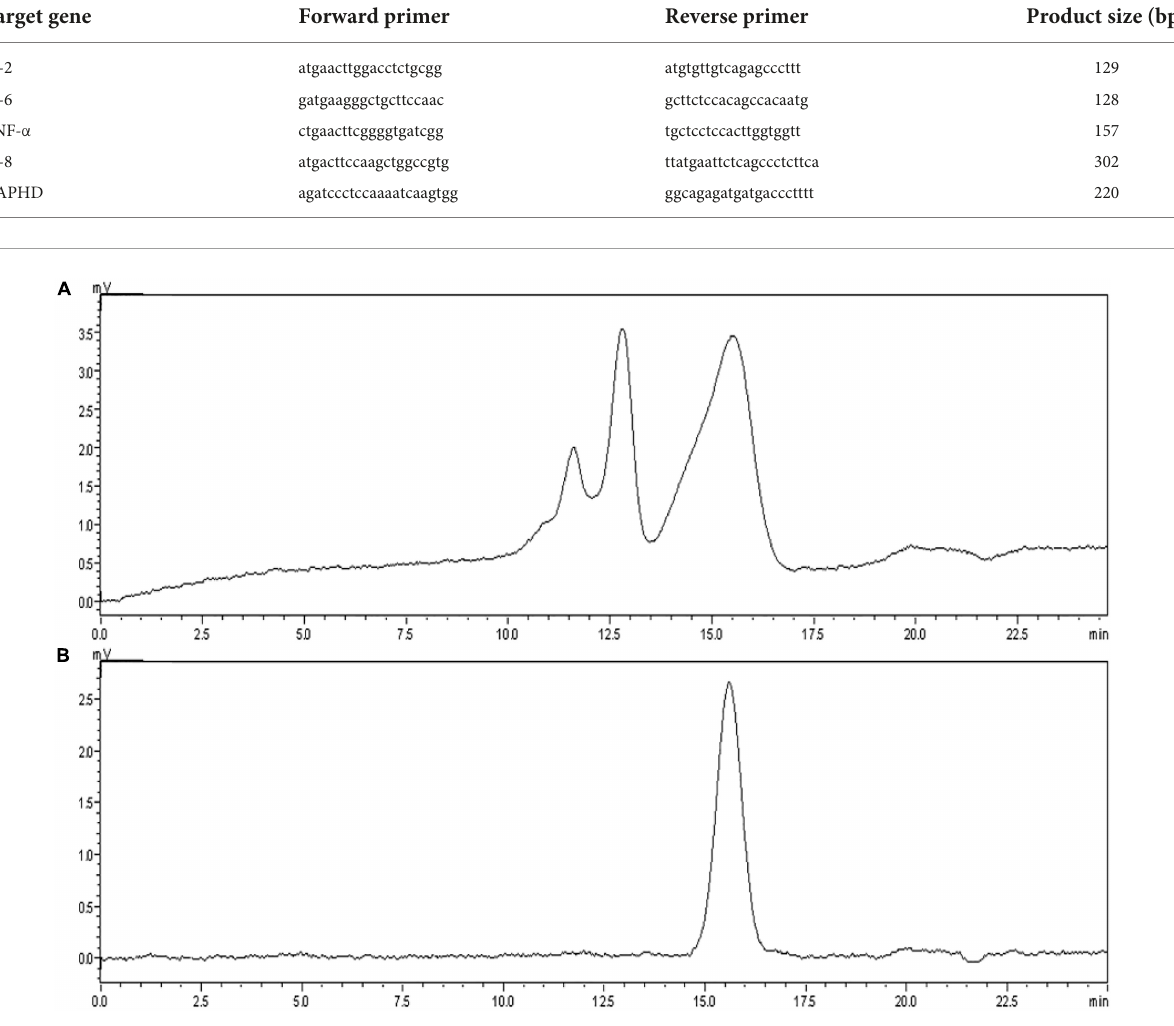
TABLE 1 Primers sequence of polymerase chain reaction (RT-qPCR).